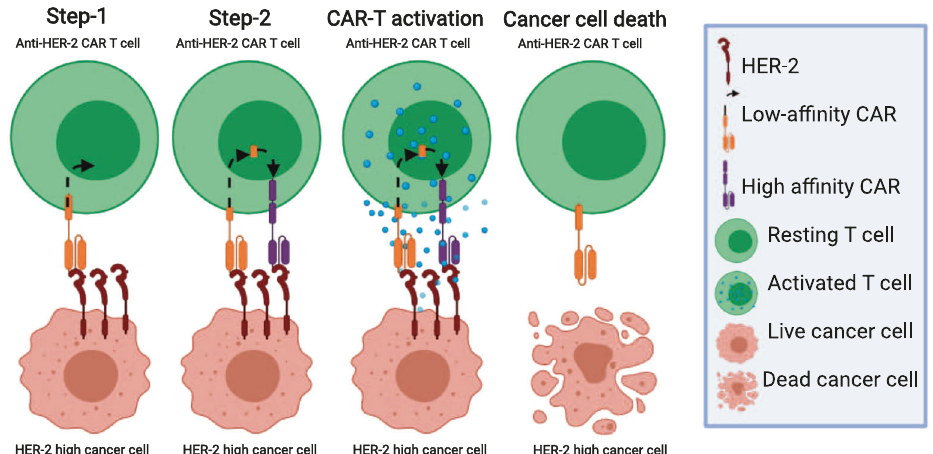
Fig. 1 CAR-T cells utilize 2-steps recognition mechanism to speci fi cally recognize and then kill cancer cells expressing high levels of HER-2. In step 1, HER-2 (in brown) high cancer cell is recognized by the low af fi nity CAR (in orange) on the CAR-T cells, which leads to the cleavage of fused transcription factor shown in step 2. This transcription factor initiate the transcription and expression of high af fi nity CAR (in purple). HER-2 high cancer cell is recognized by the high af fi nity CAR, which activates the CAR-T cell, ultimately leading to the killing of the HER-2 high cancer cell. Created with